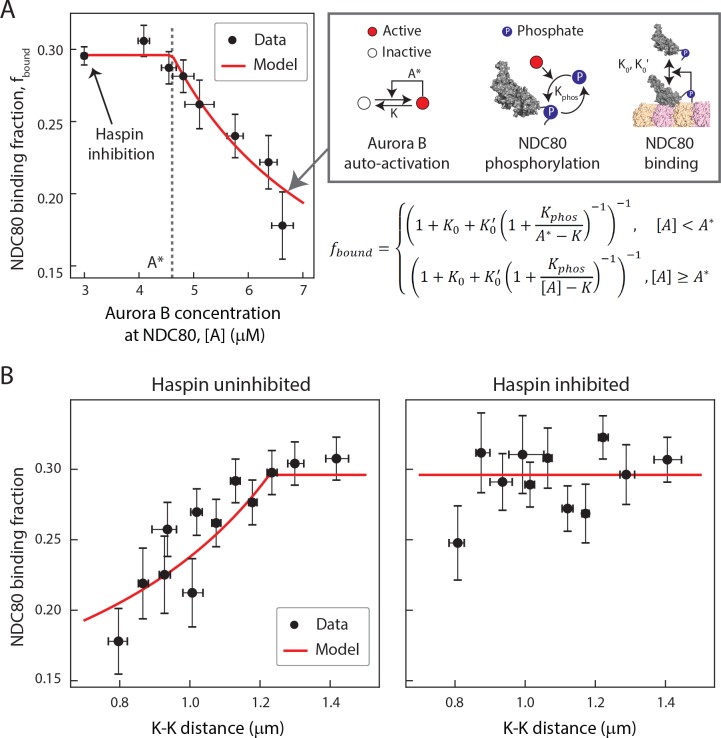
A biophysical model of tension dependent NDC80-kMT binding.(A) Plot of NDC80 binding fraction, fbound, (converted from NDC80 FRET fraction in Figures 3D and 5E) vs. Aurora B concentration at NDC80, [A] (converted from INCENP-mCherry intensity in Figure 6B, see Materials and methods). Data points (black circles) are the mean and SEM. We constructed a mathematical model that predicts NDC80 binding fraction from Aurora B concentration at NDC80 through three steps: intermolecular Aurora B auto-activation, NDC80 phosphorylation, and NDC80-kMT binding. Red line shows the mathematical model fit to the data. (B) NDC80 binding fraction vs. K-K distance before (left) and after (right) haspin inhibition by 5-ITu. The data points (black circles) are adapted from Figures 3D and 5E. Red lines are the predictions from the mathematical model. Data points are available in Figure 7-Data (Yoo et al., 2018).